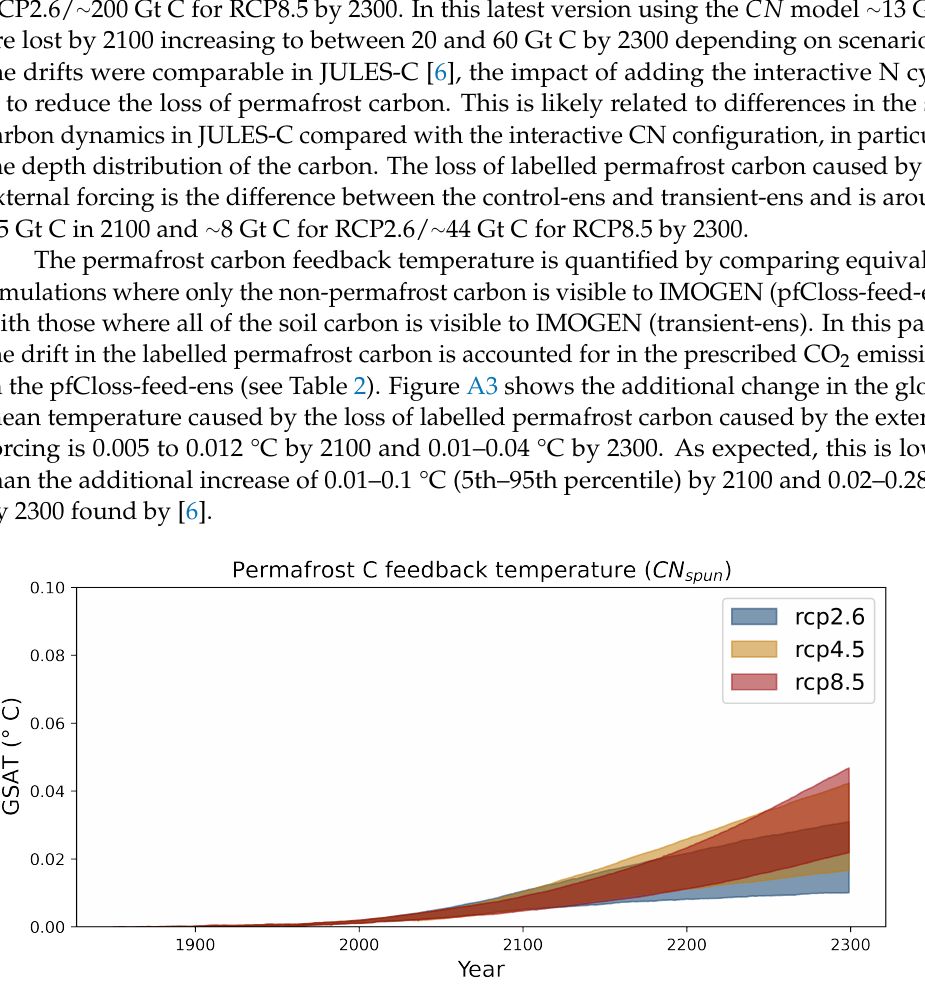
Figure A3. The permafrost carbon feedback temperature for the three different future scenarios for CN spun